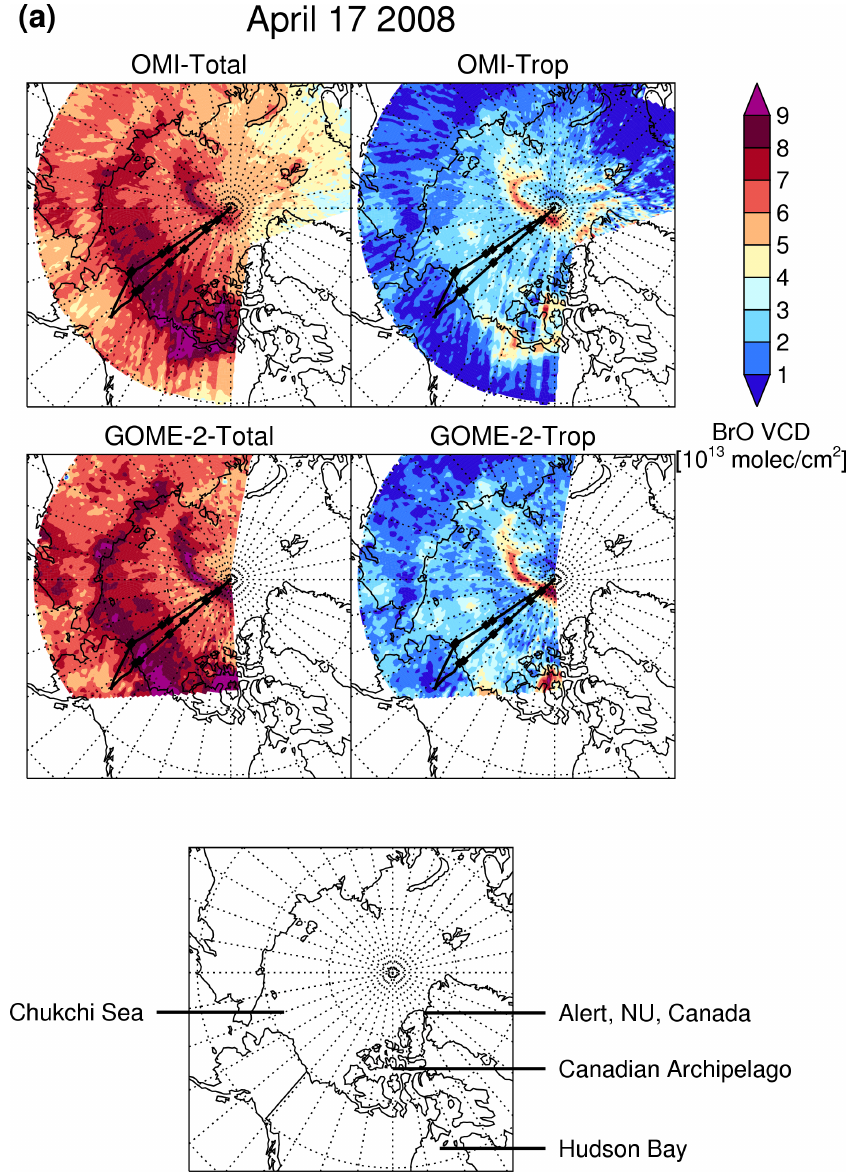
Fig. 6a. Maps on 17 April 2008 of (top left) OMI total vertical column density (VCD) of BrO, (top right) inferred OMI tropospheric VCD of BrO, (middle left) GOME-2 total VCD of BrO, and (middle right) inferred GOME-2 tropospheric VCD of BrO column. Negative values are included as dark blue. The flight track of the DC-8 on 17 April 2008 is indicated by black lines; aircraft profile locations where BrO was measured are marked with black diamonds. Geographic regions used in the paper are denoted in the bottom panel.